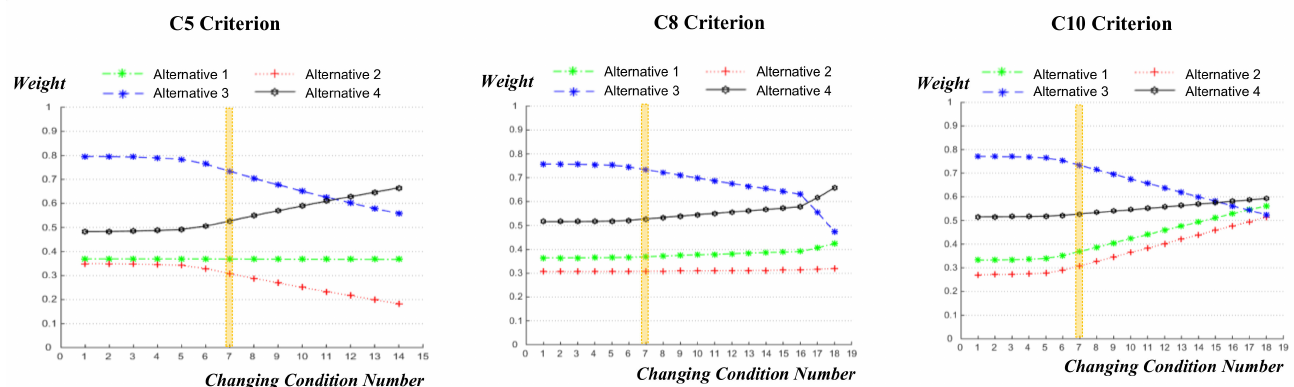
Figure 8. Sensitivity analysis results of sub-criteria C5, C8 and